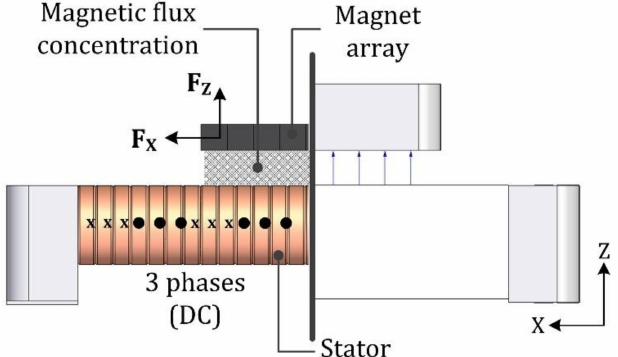
Figure 1. Orthogonal forces in Halbach linear motor.